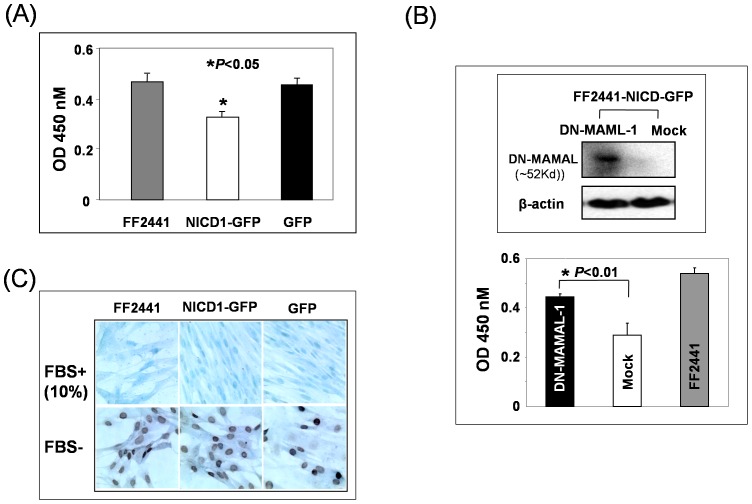
Effects of Notch activation and inhibition on human dermal fibroblast growth.Notch activation slows down cell growth rate of fibroblasts. Proliferation of transduced FF2441 cells was determined by MTT assays (A). Activated Notch1 inhibited cell growth of fibroblasts. (B) Inhibition of Notch activation by ectopic expression of DN-MAML-1 (upper) in FF2441-NICD-GFP cells relieves cell growth inhibition as measured by MTT assay (lower). Data are presented as mean ± SD of three independently performed experiments in (A) and (B). (C) Notch activation does not induce cell apoptosis in fibroblasts. Cell apoptosis was determined by TUNEL assay. No obvious apoptotic cells were detectable in FF2441-NICD1-GFP cells. Serum starvation-induced cells were used as positive control (FBS-).